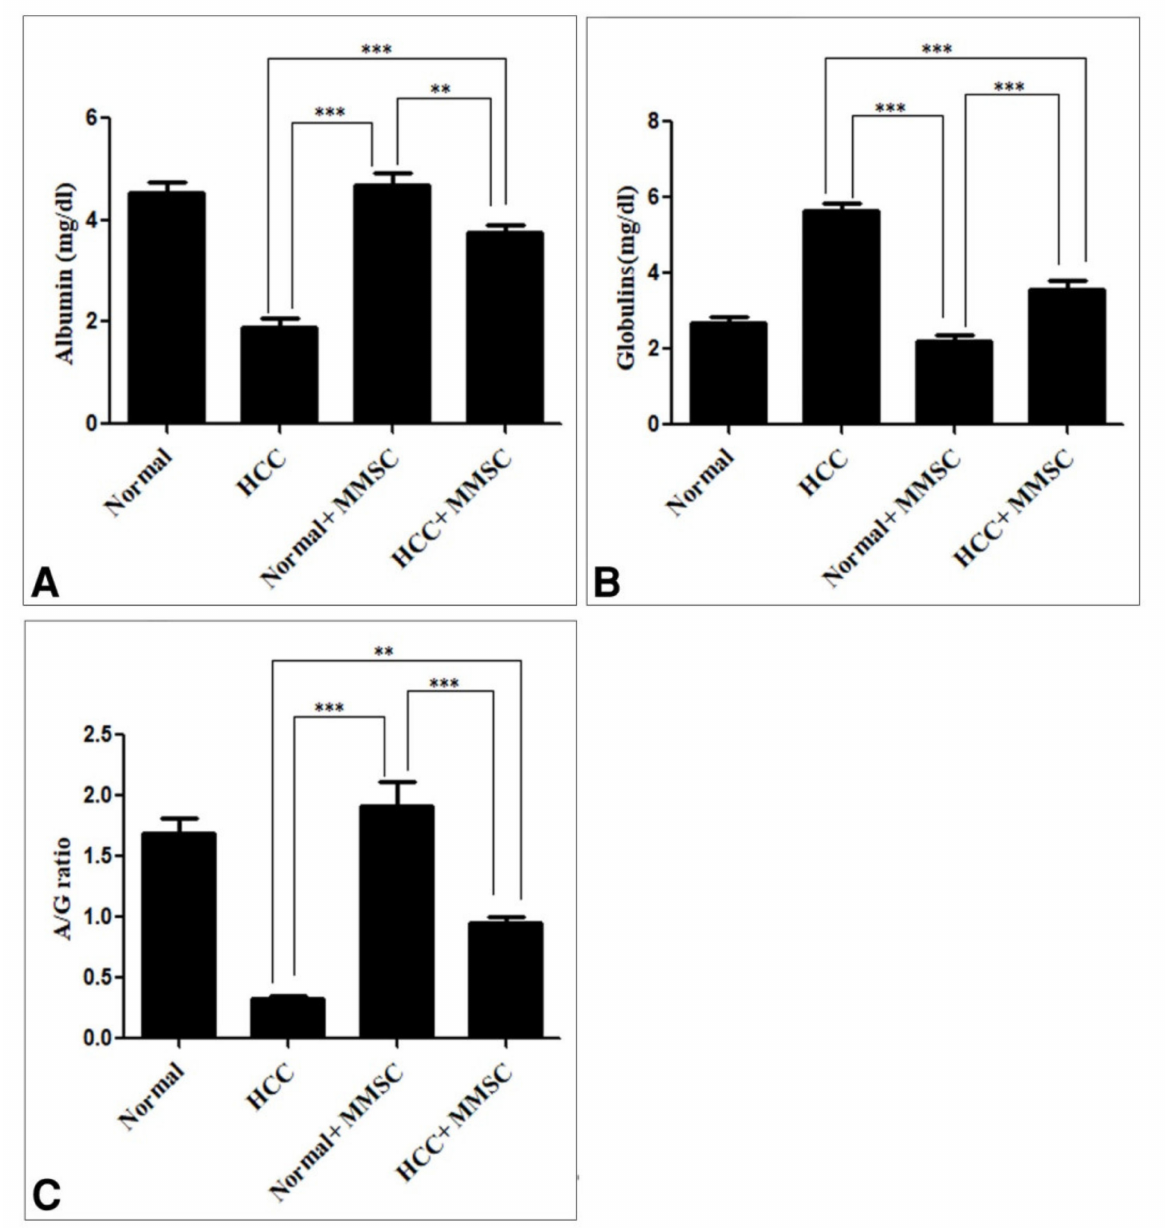
Figure 2. The serum level of ( A ) albumin, ( B ) globulin, and ( C ) the albumin/globulin (A/G) ratio. Data were presented as mean ± SEM. ** Significantly different at p < 0.001, *** Significantly different at p < 0.0001 using ANOVA followed by Bonferroni’s as a post-hoc test. Hepatocellular carcinoma (HCC), S-methylmethionine sulfonium chloride